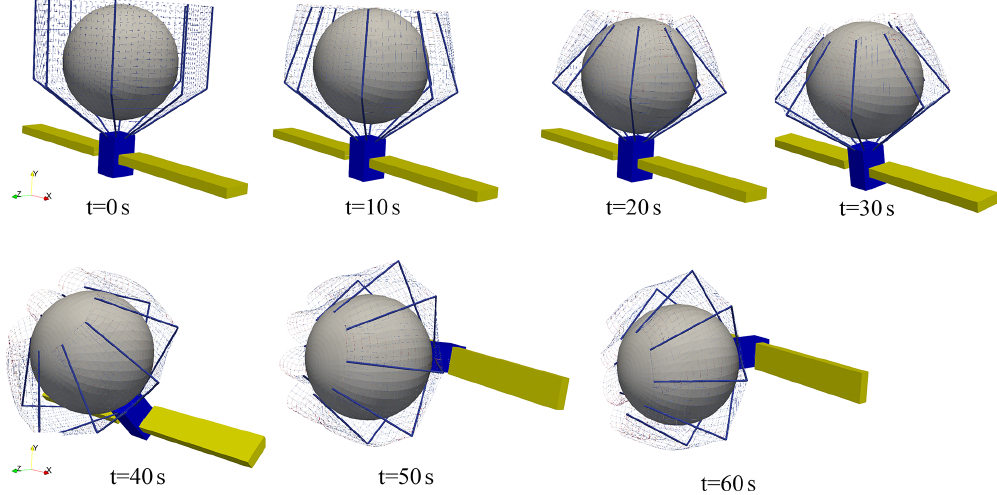
Figure 6. Capturing and attitude maneuver process.